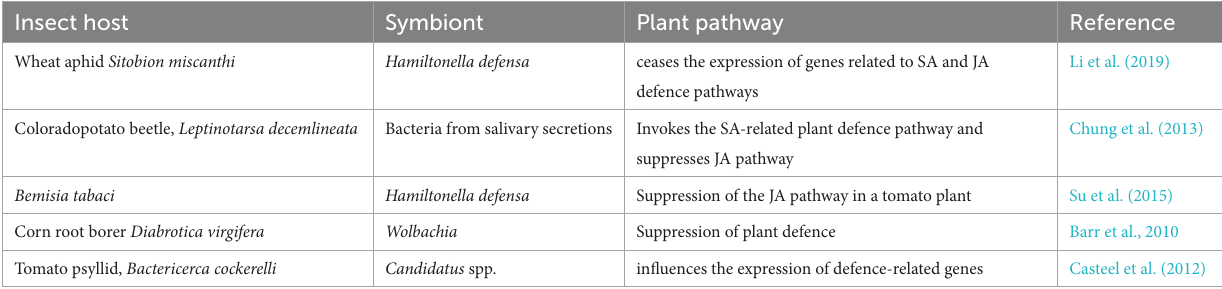
TABLE 2 List of symbionts acting against plant